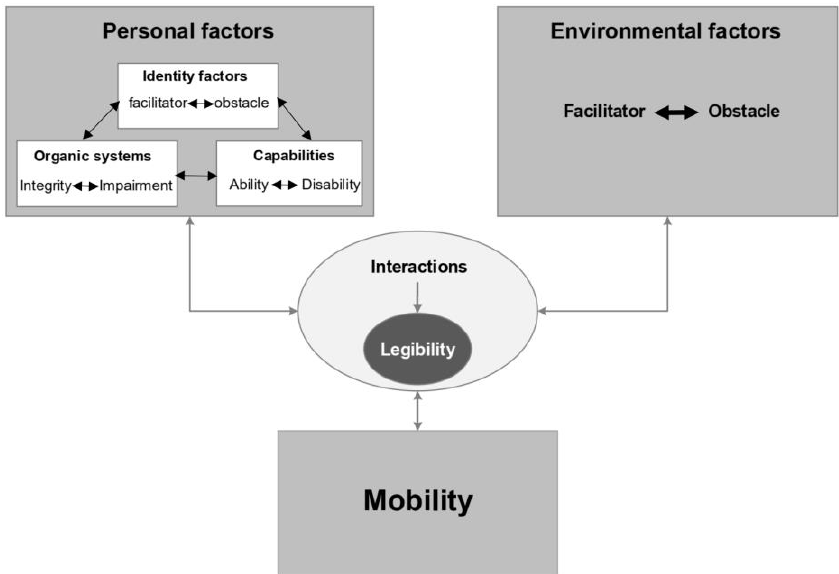
Figure 1. Legibility as a result of interactions between personal and environmental factors for mobility tasks in the Disability Creation Process (DCP) model.